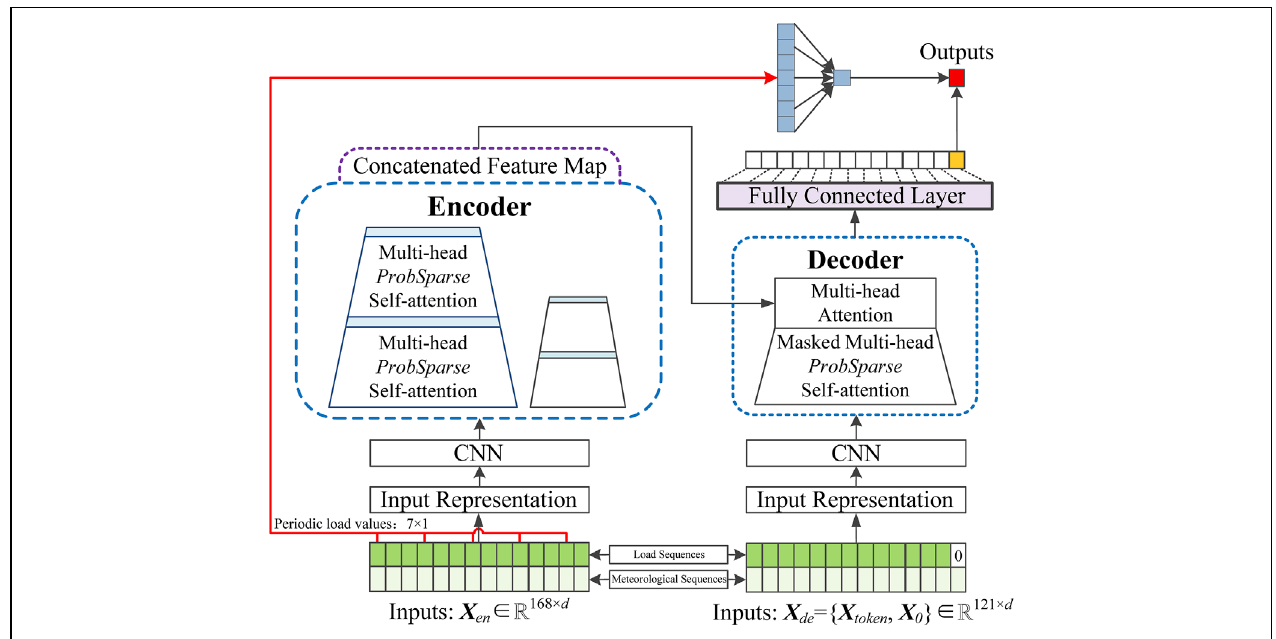
FIGURE 1 | Pipeline of the proposed short-term load forecasting